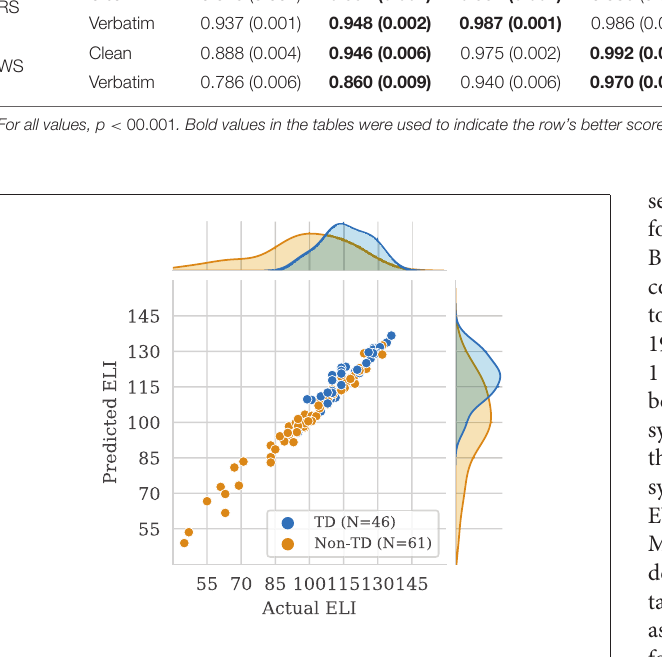
FIGURE 3 | Correlations of actual vs. automatically predicted Expressive Language Index (ELI) composite scores. Distributions are shown for participants with and without developmental language disorder (DLD). Each point represents the average scores for one